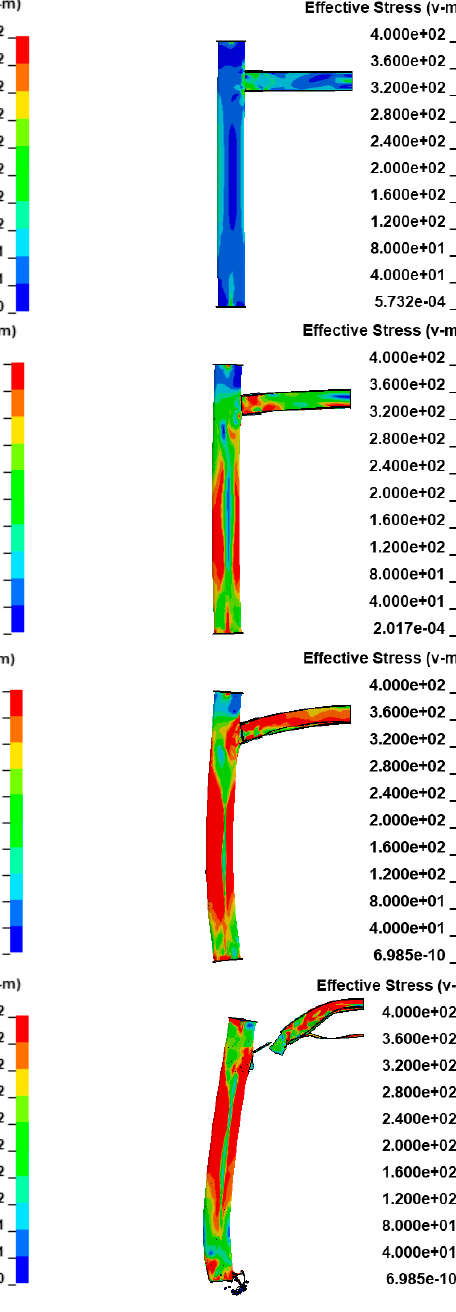
Figure 12. Simulation results for large CFT connections at t = 20 ms. ( a ) W = 227 kg; ( b ) W = 454 kg; ( c ) W = 1814 kg; ( d ) W = 4536 kg; ( e ) W = 11.000 kg.